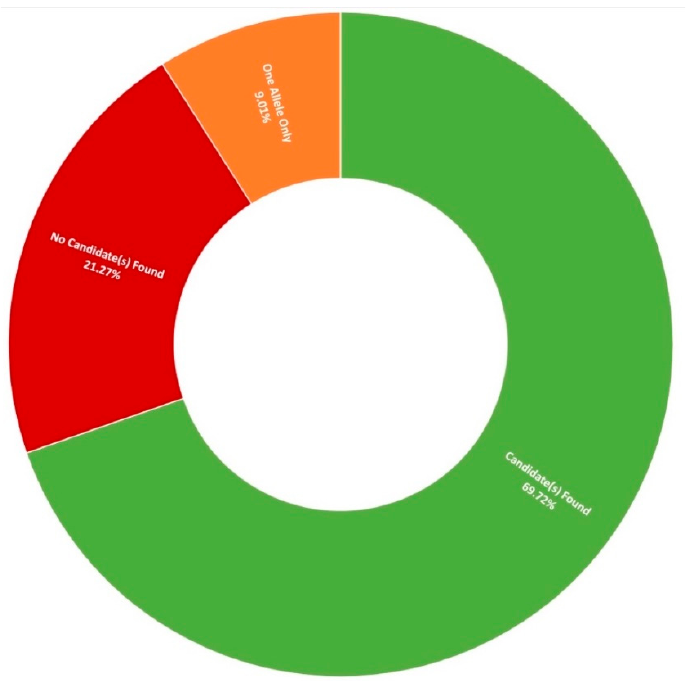
Figure 1. Clinical presentation of 1004 recruited Target 5000 pedigrees. RP: Retinitis Pigmentosa, FFM: Fundus Flavimaculatus, MD: Macular Dystrophy, CRD: Cone-Rod Dystrophy, RCD: Rod-Cone Dystrophy, LCA: Leber Congenital Amaurosis, EOSRD: Early-Onset Retinal Degeneration, BBS: Bardet-Biedl Syndrome, CSNB: Congenital Stationary Night Blindness (Table S2).